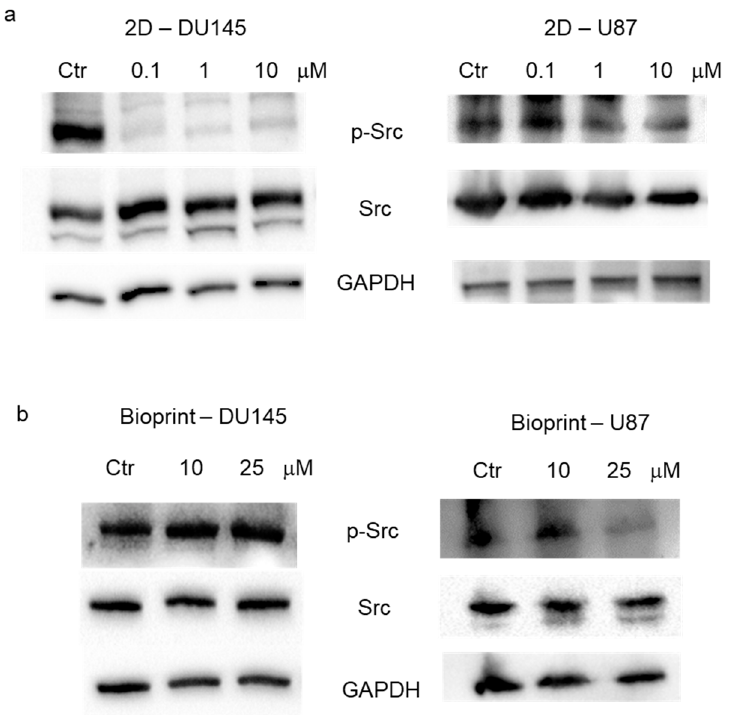
Figure 3. Evaluation of Src activation. ( a ) Western blot analysis of total cell lysates from DU145 ( left ) and U87 ( right ) cells cultured in standard conditions (2D). Cell lysates were recovered 24 h after dasatinib treatment with increasing concentrations (0.1, 1, and 10 μ M) and analyzed for the expression of pSrc (Tyr416), total Src, and GAPDH (loading reference). ( b ) Western blot analysis of total cell lysates from DU145 ( left ) and U87 ( right ) cells cultured alginate/gelatin bioprinted scaffold (bioprint). Bioprints were treated for 24 h with 10 or 25 μ M dasatinib and analyzed for the expression of pSrc (Tyr416), total Src, and GAPDH (loading reference).